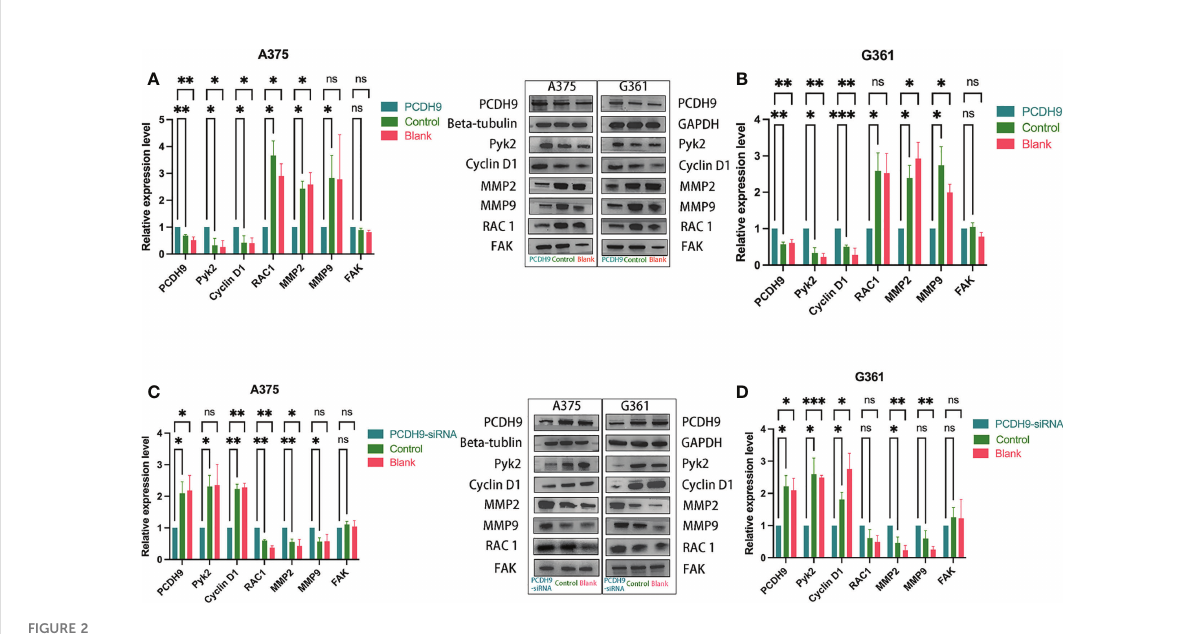
FIGURE 2 Effects of PCDH9 overexpression and KD in melanoma cells measured by Western blot. Overexpressing PCDH9 signi fi cantly upregulated levels of Pyk2 and Cyclin D1 and downregulated RAC1, MMP2, and MMP9 in A375 (A) and G361 (B) cells. KD of PCDH9 downregulated levels of Pyk2 and Cyclin D1 and upregulated RAC1, MMP2, and MMP9 in A375 (C) and G361 (D) cells. ns P > 0.05, * p < 0.05, ** p < 0.01, and *** p < 0.001 compared groups using one-way ANOVA followed by least signi fi cant difference post-hoc tests.